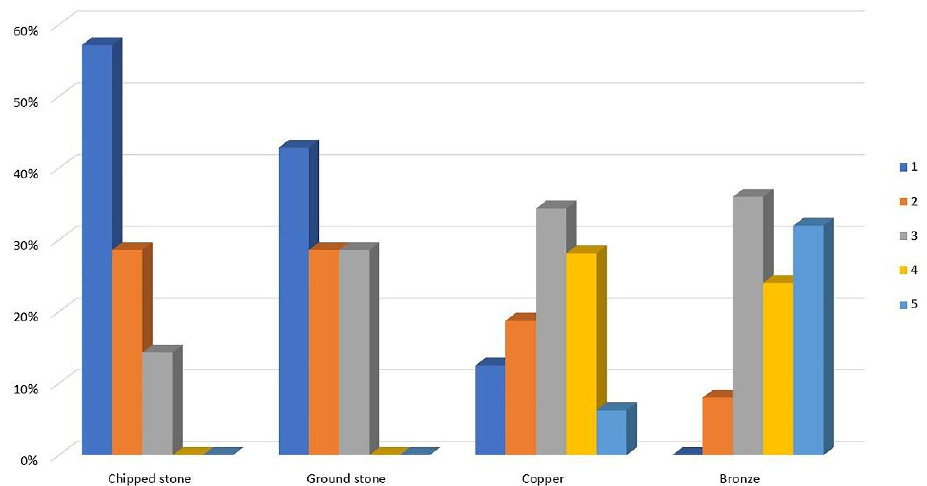
Figure 9. Frequency distribution of experimental axe types (left to right: chipped stone, ground stone, copper, and bronze) by Fragmentation Class (1–5).